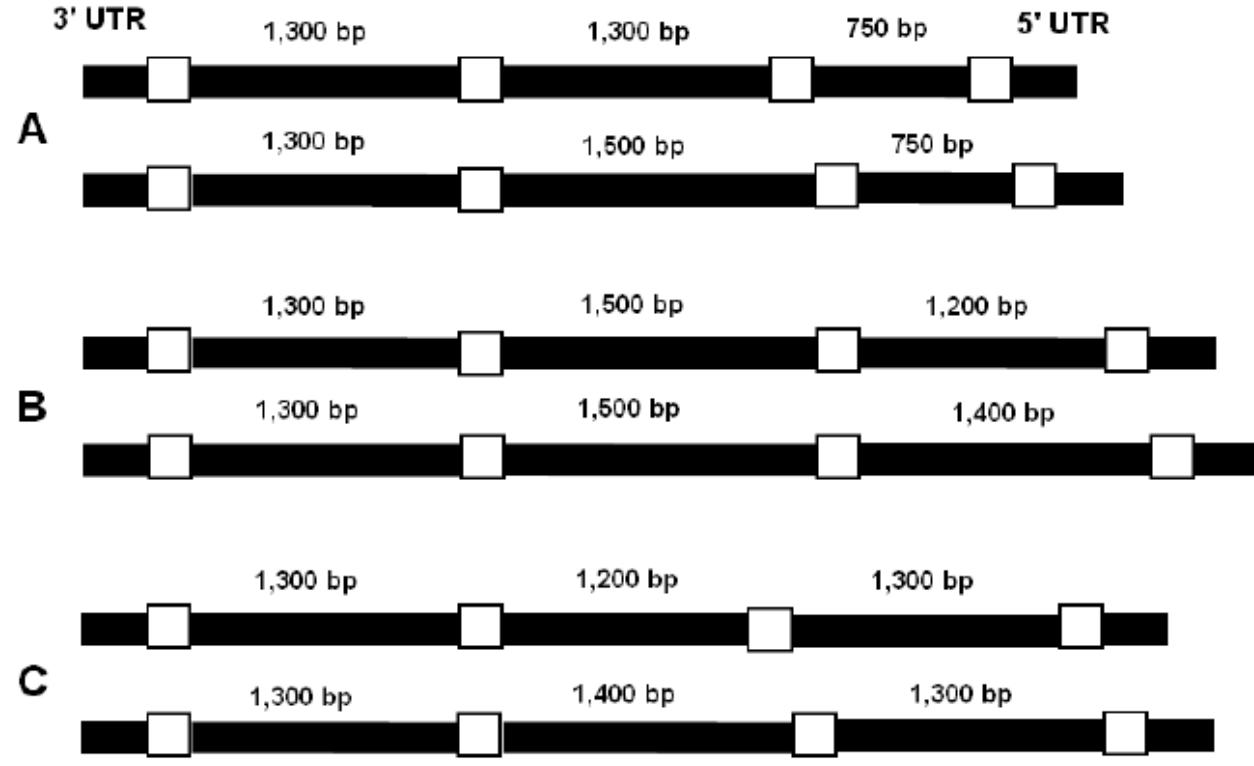
Figure 4. Schematic representation of the supposed alleles from ( A ) B. glabrata , ( B ) B. straminea , and ( C ) B. tenagophila according to amplicons obtained. Exons (white) were represented only to delimit introns